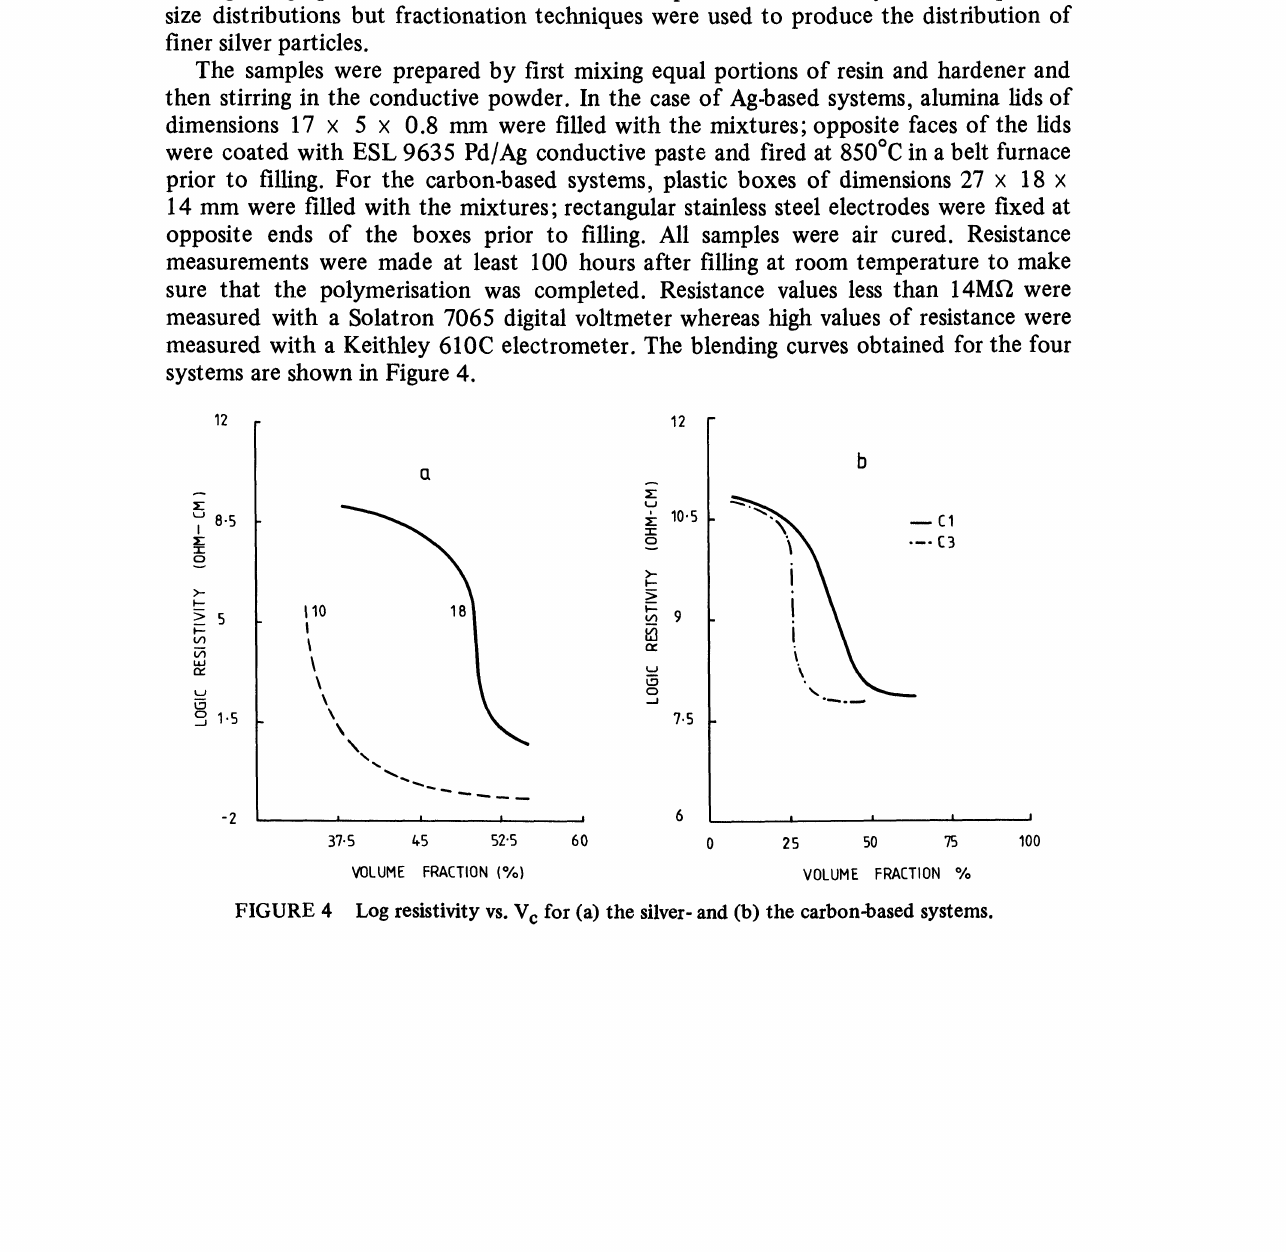
FIGURE 4 Log resistivity vs. V e for (a) the silver- and (b) the carbon-based